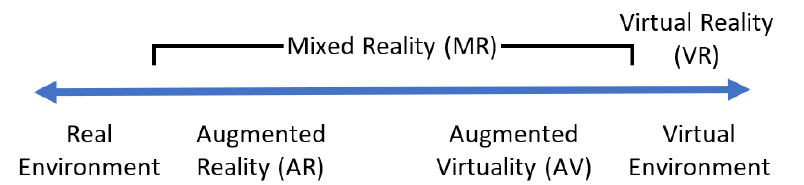
Figure 2. The reality–virtuality continuum introduced by Milgram and Kishino